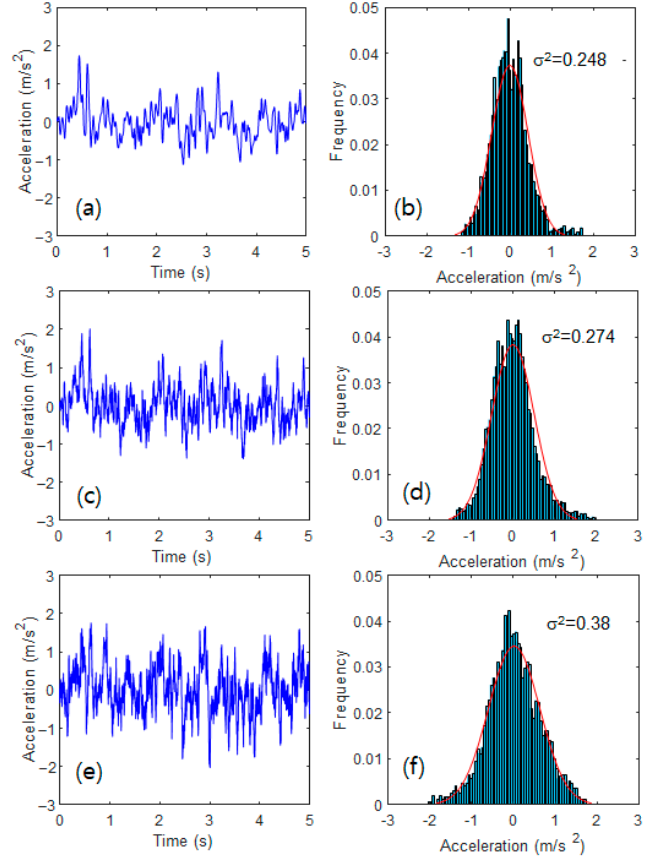
Figure 15. Gaussian random noises for robustness evaluation; ( a , b ) original extracted from the